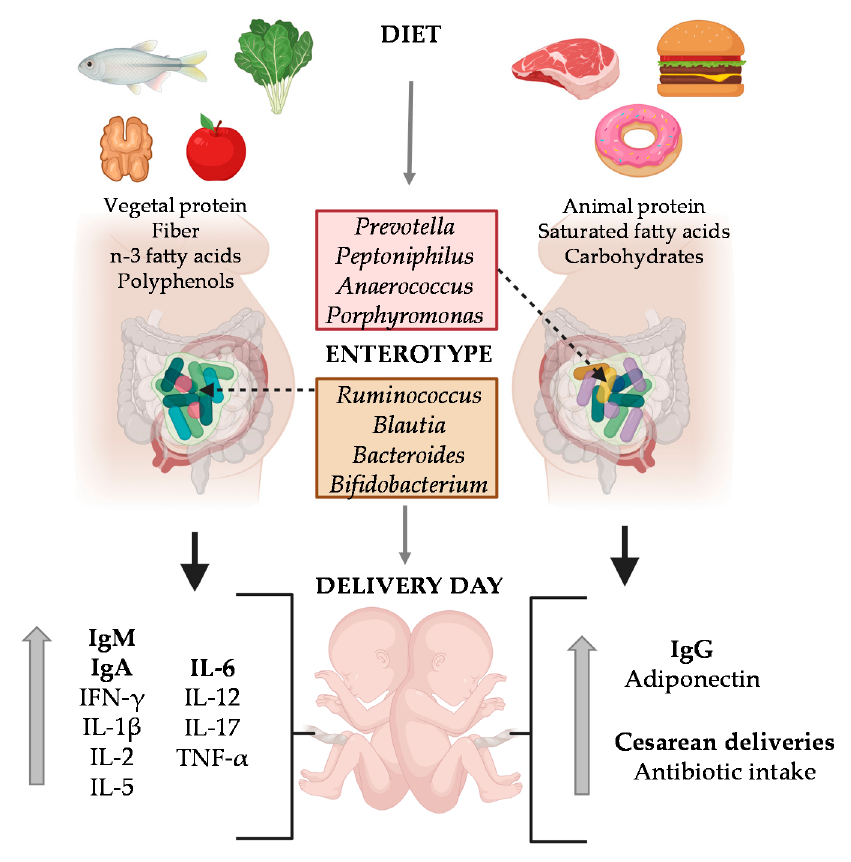
Figure 7. Influence of diet on enterotype, umbilical cord composition and parturition outcomes. The factors marked in bold are the most significant. Created with BioRender.com